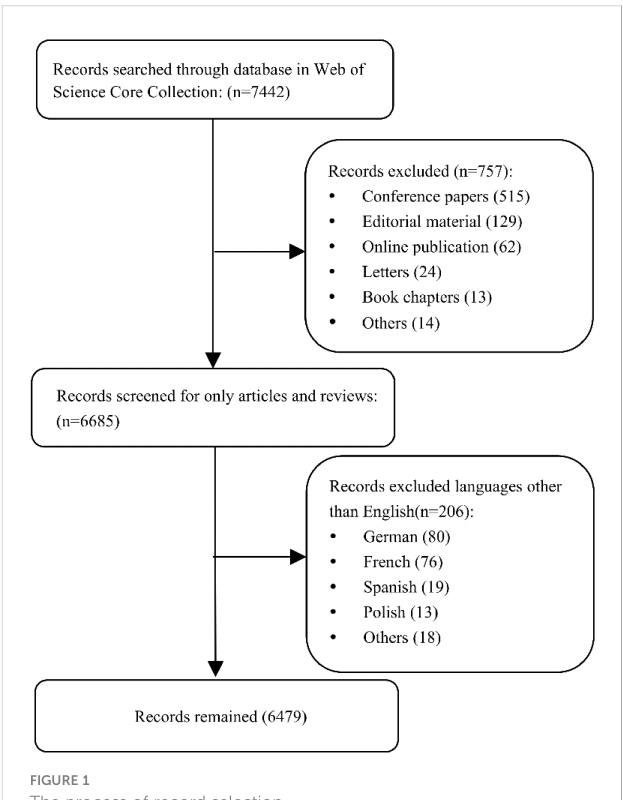
FIGURE 1 The process of record